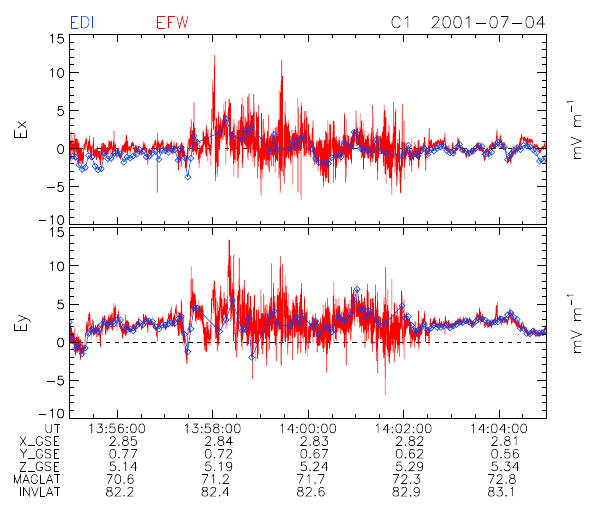
Fig. 8. Detail of part of the data in Fig. 6, with EFW (red) and EDI (blue) data at full time resolution in the plasma sheet boundary layer.